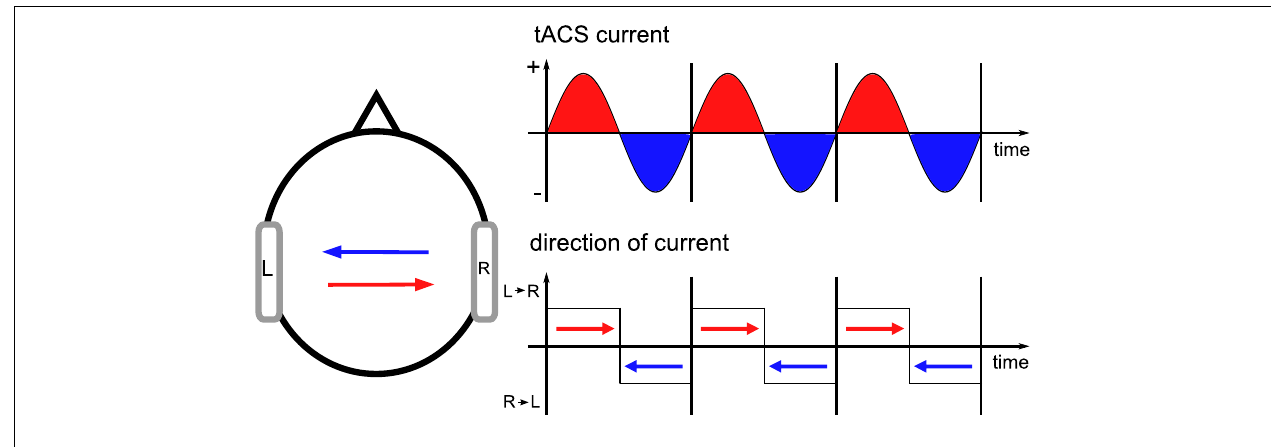
variable amplitude. During the negative half-wave, the direction of current flow suddenly flips by 180˚. During each half-wave the direction remains stable but the strength of the current flow varies. Stimulation electrodes are depicted in